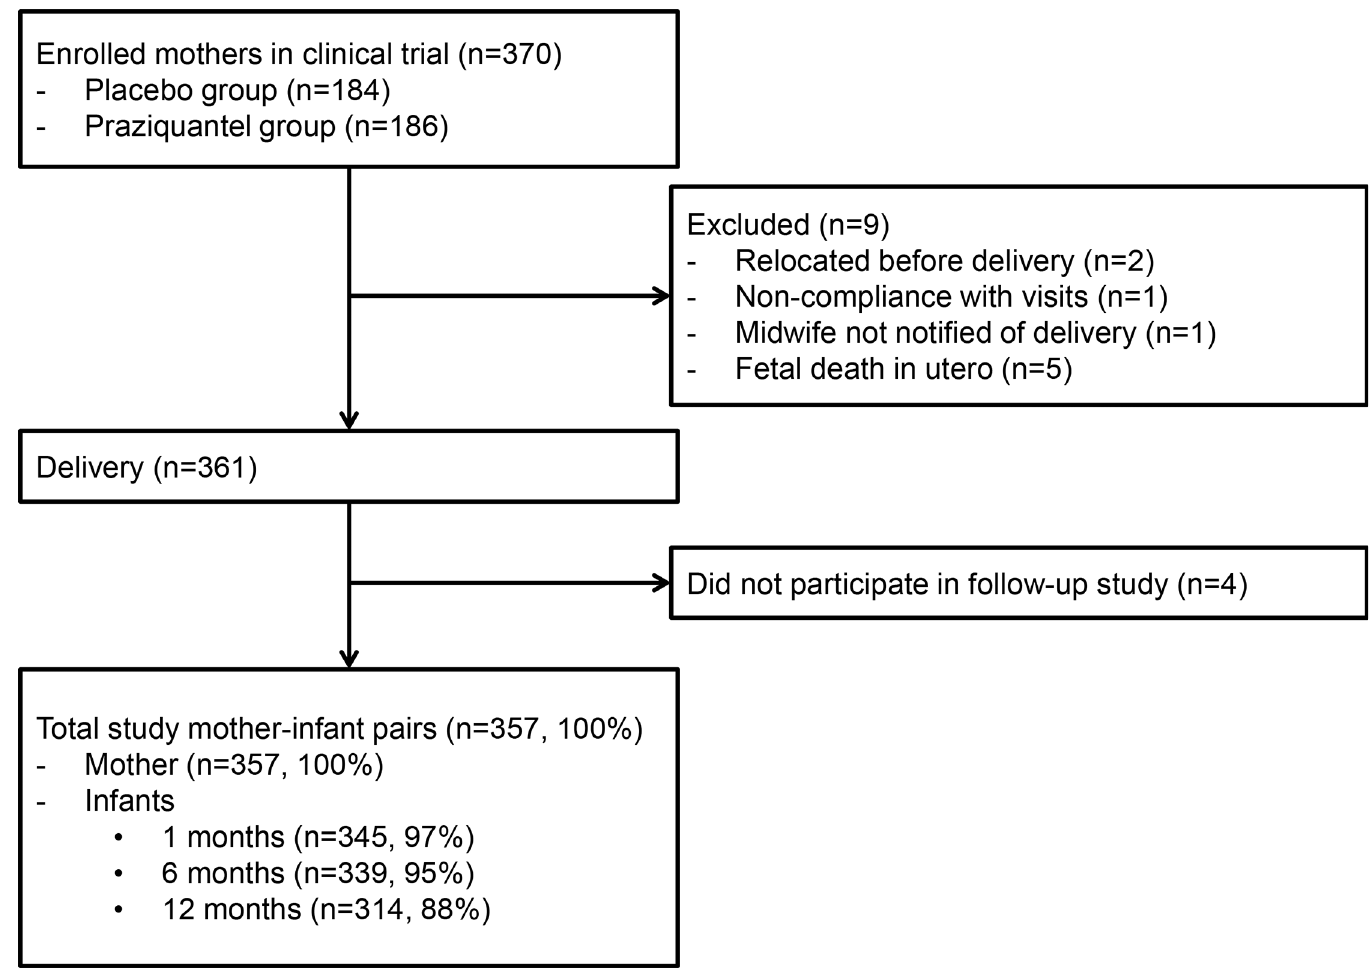
Fig 1. Flow of participants.